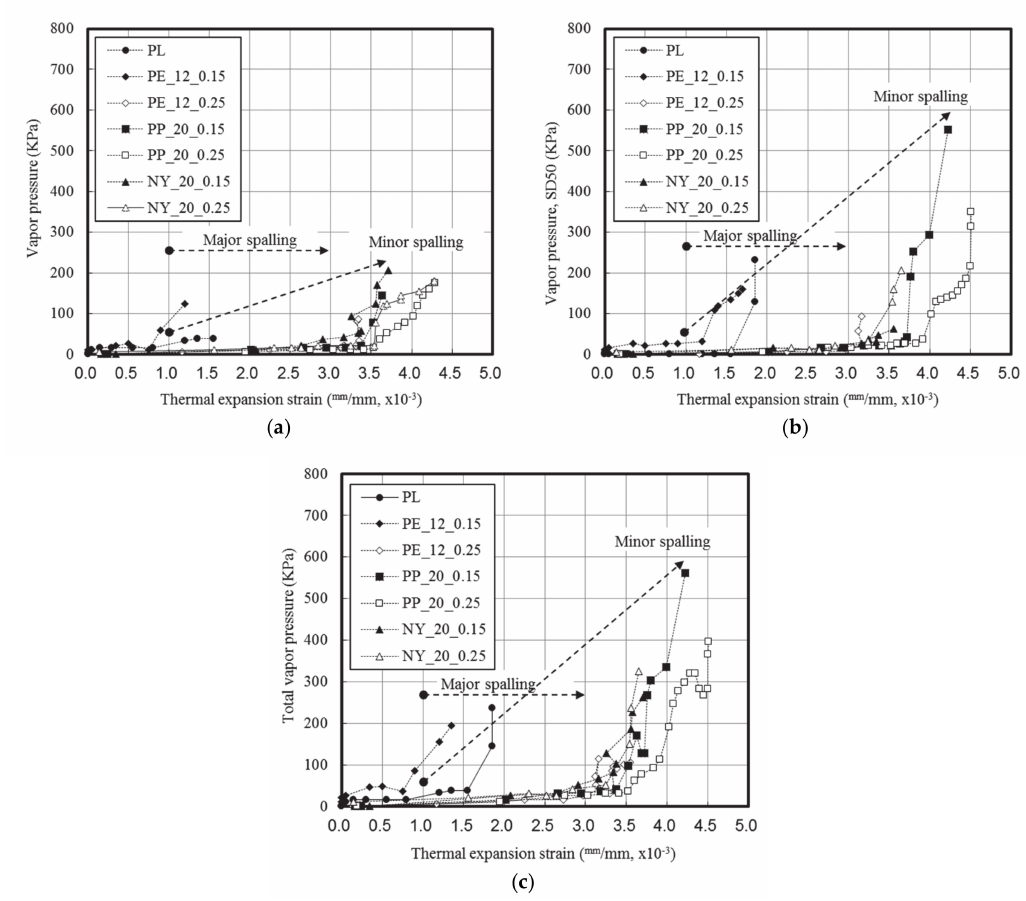
Figure 12. Relationship between thermal strain and water vapor pressure: ( a ) Distance from surface, 30 mm; ( b ) distance from surface, 50 mm; ( c ) accumulated